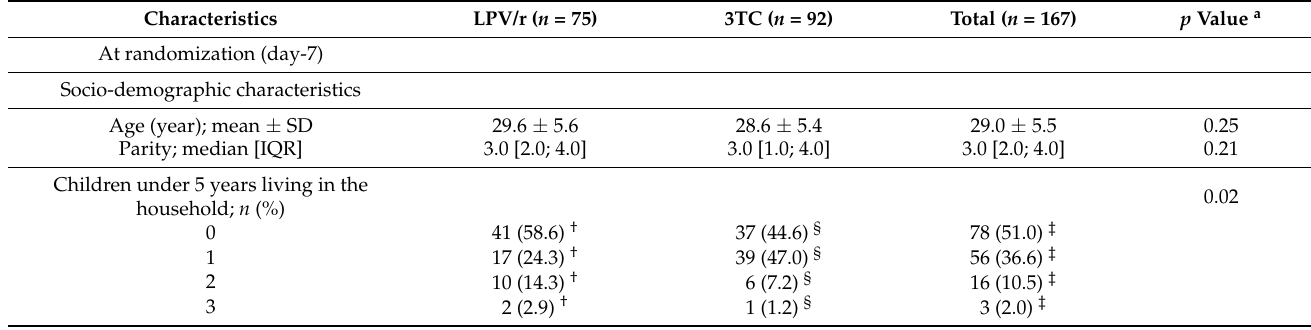
Table 2. Maternal characteristics at randomization (day-7) and during the PROMISE PEP trial follow-up.